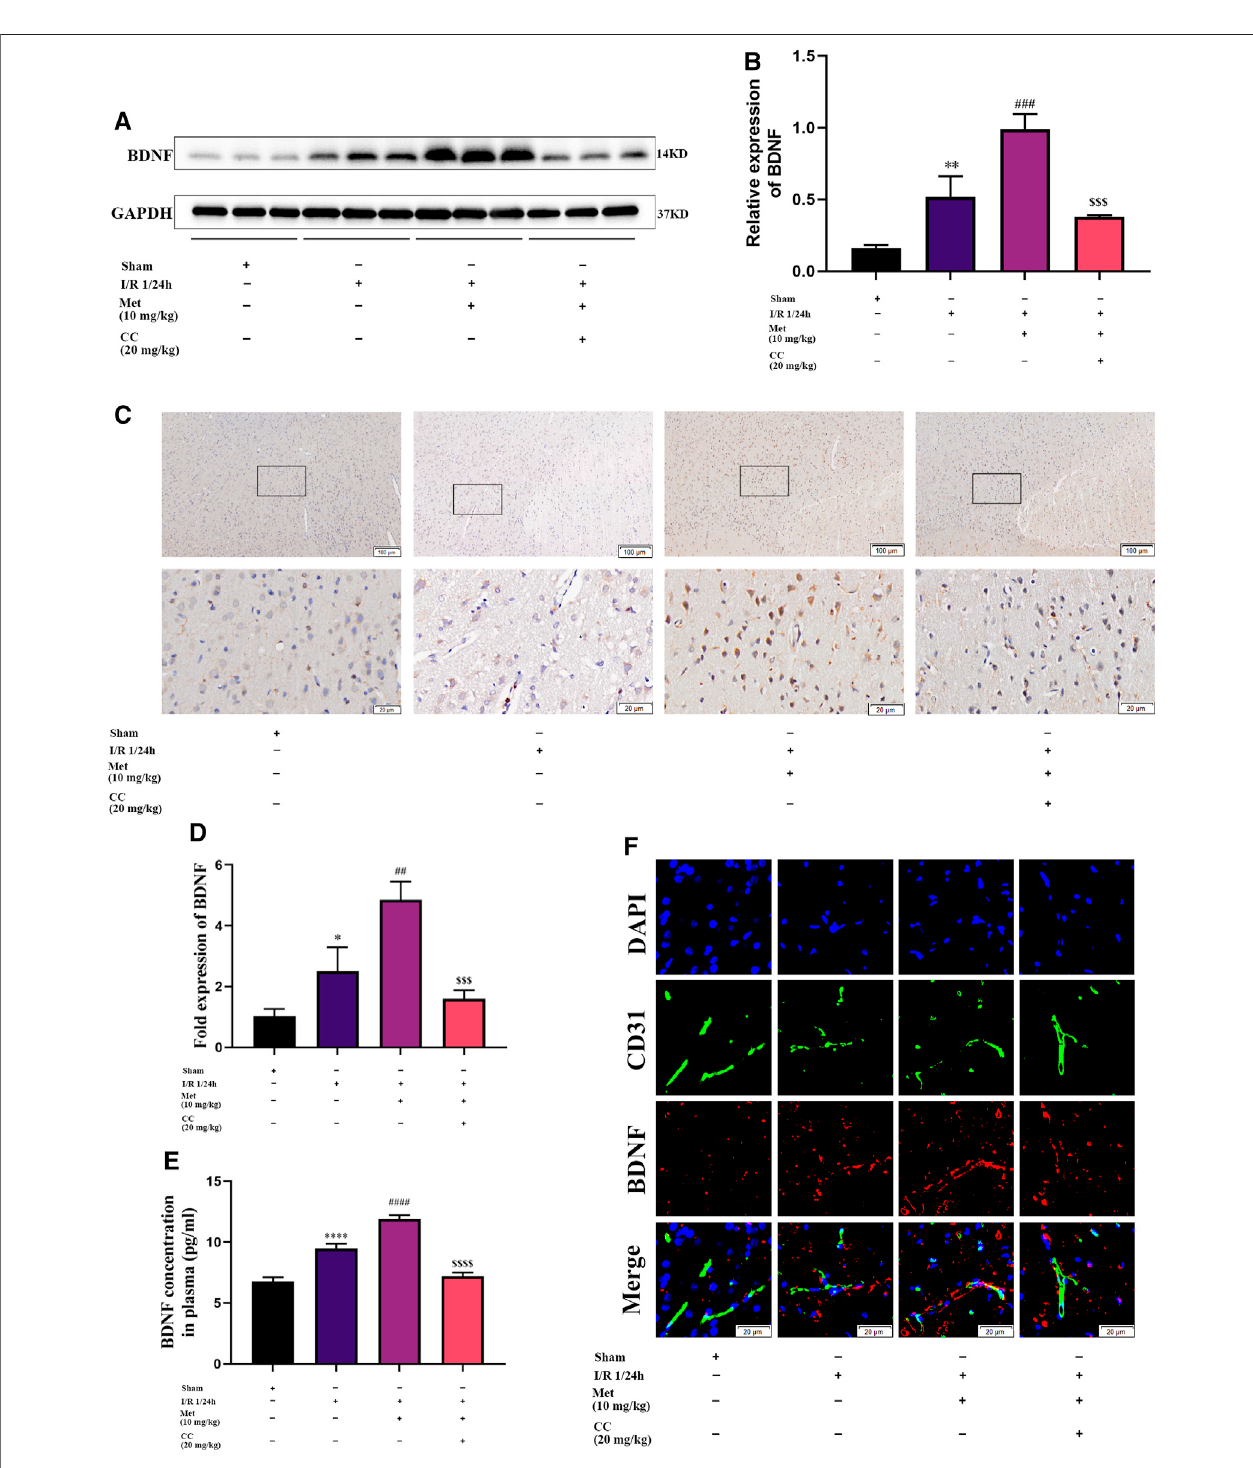
FIGURE 3 | Metformin improves cerebral ischemia/reperfusion (I/R) injury by regulating the expression of BDNF. (A – C) BDNF protein expression in the ischemic penumbra area was evaluated by western blotting and immunohistochemistry ( n = 3, bar = 100 μ m/20 μ m). (D) The BDNF transcription level in the ischemic penumbra area was assessed by RT-qPCR ( n = 3). (E) The BDNF concentration in the plasma assessed by ELISA ( n = 3). (F) BDNF expression in endothelial cells in the ischemic penumbra was evaluated by immuno fl uorescence staining ( n = 3, bar = 20 μ m). (* p < 0.05, ** p < 0.01, **** p < 0.0001 vs. sham; ## p < 0.01, ### p < 0.001, #### p < 0.0001 vs. I/R 1/24 h; $$$ p < 0.001, $$$$ p < 0.0001 vs. I/R 1/24 h + Met).